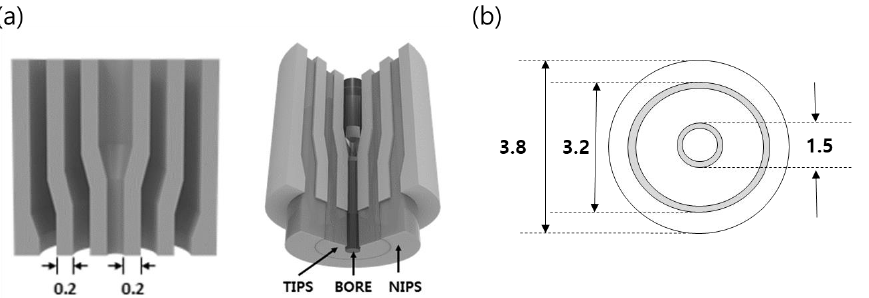
Figure 2. Schematic diagram of the triple orifice spinneret (TOS): ( a ) Cross section of the TOS. The dope solutions are pumped simultaneously to three line of the TOS, ( b ) Dimension of the TOS (unit: mm).